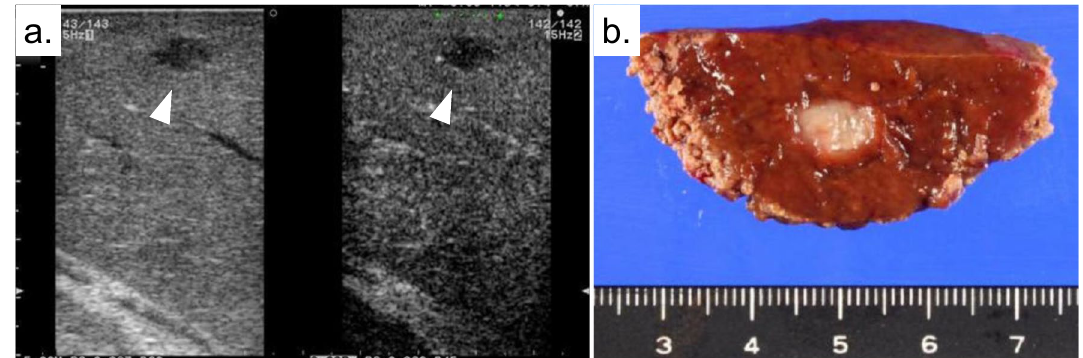
Fig. 2 Operative findings . a Contrast-enhanced ultrasonography with perfluorobutane microbubbles during the operation, and b the resected specimen of liver segment 8